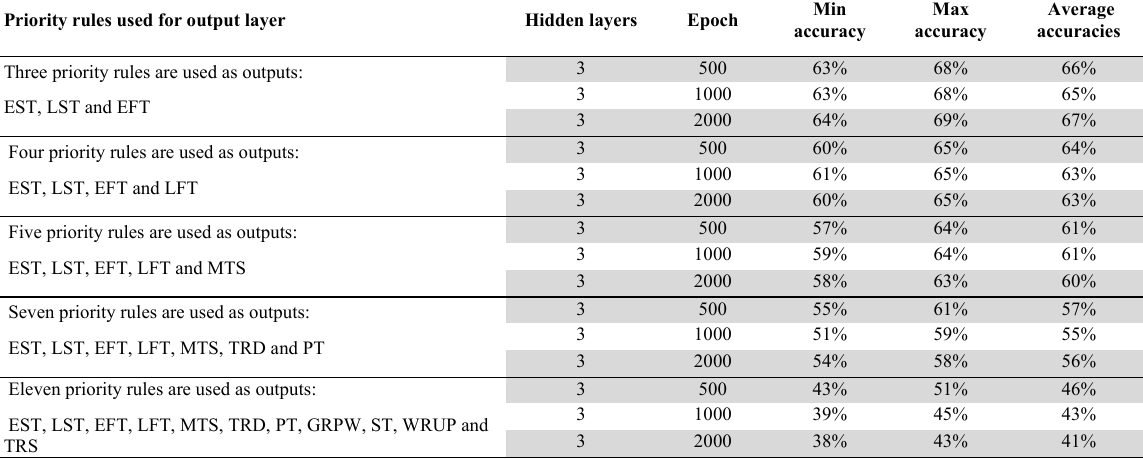
Training performance of developed MLFNN with three hidden layers Priority rules used for output